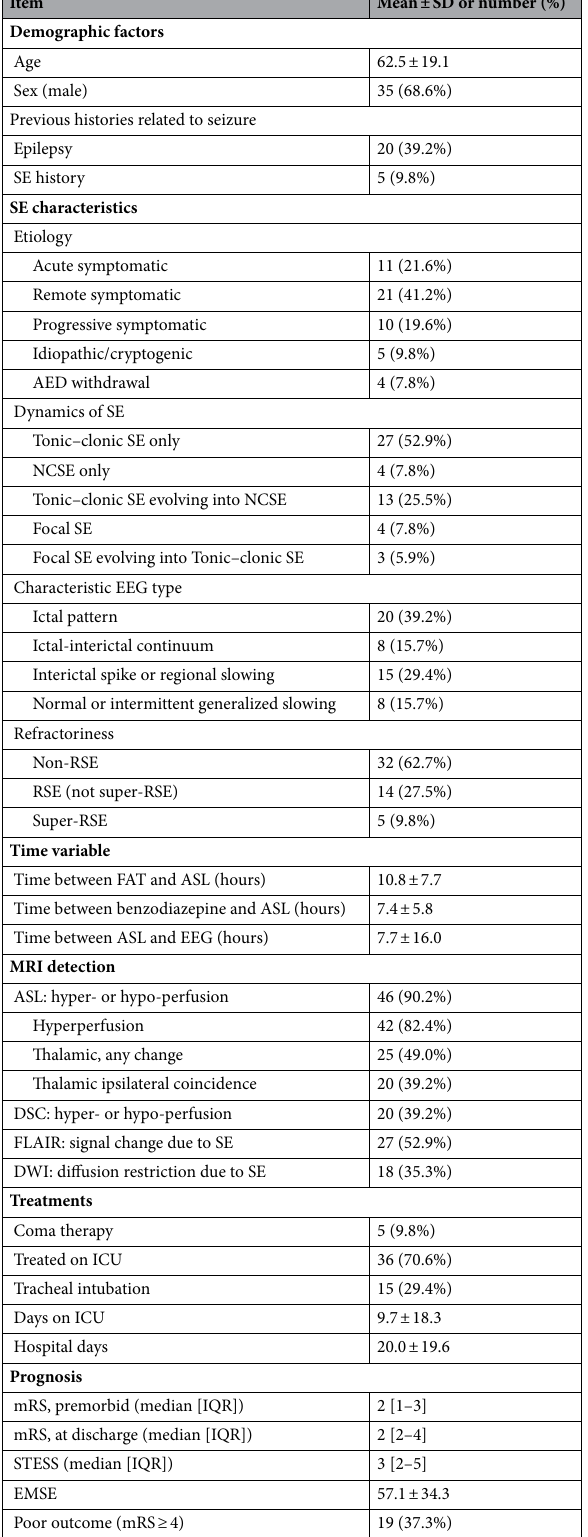
Table 1. Clinical characteristics of 51 patients with status epilepticus. SD standard deviation, SE status epilepticus, AED antiepileptic drug, NCSE nonconvulsive SE; EEG electroencephalography, RSE